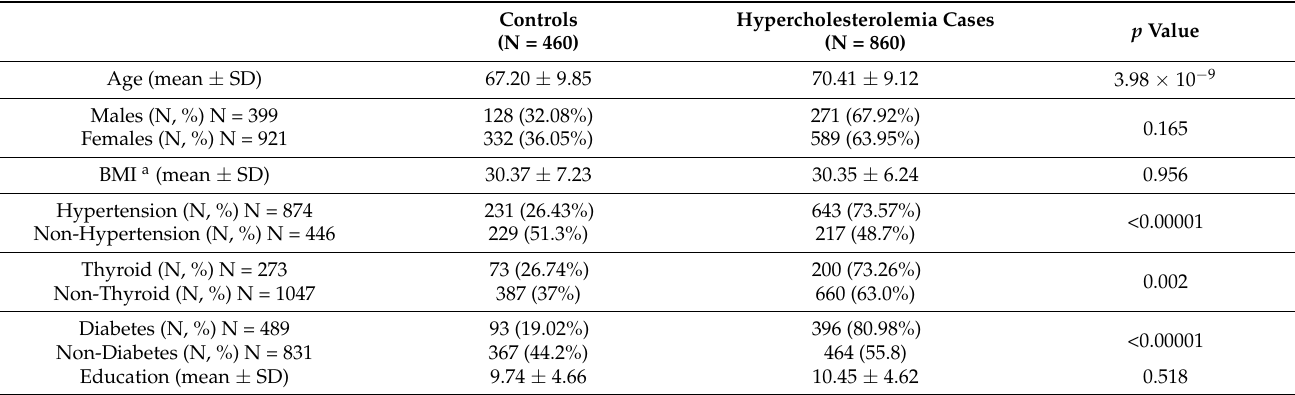
Table 1. Results of chi-square 2 analysis and t -test for demographic and health characteristics in